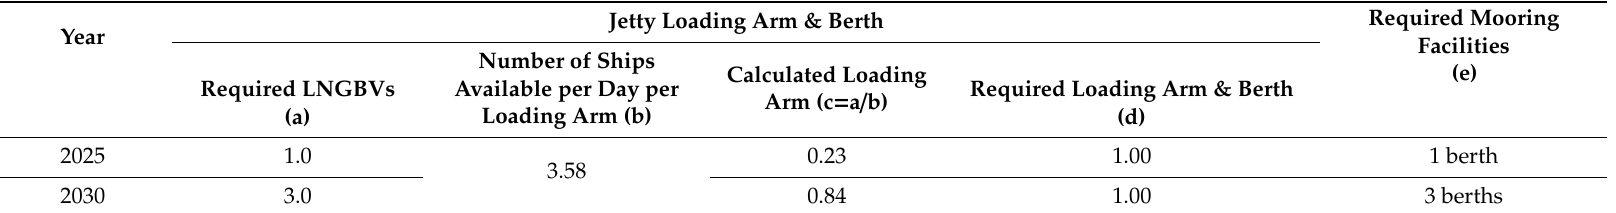
Table A14. STS Jetty Loading Arm and Mooring Facilities